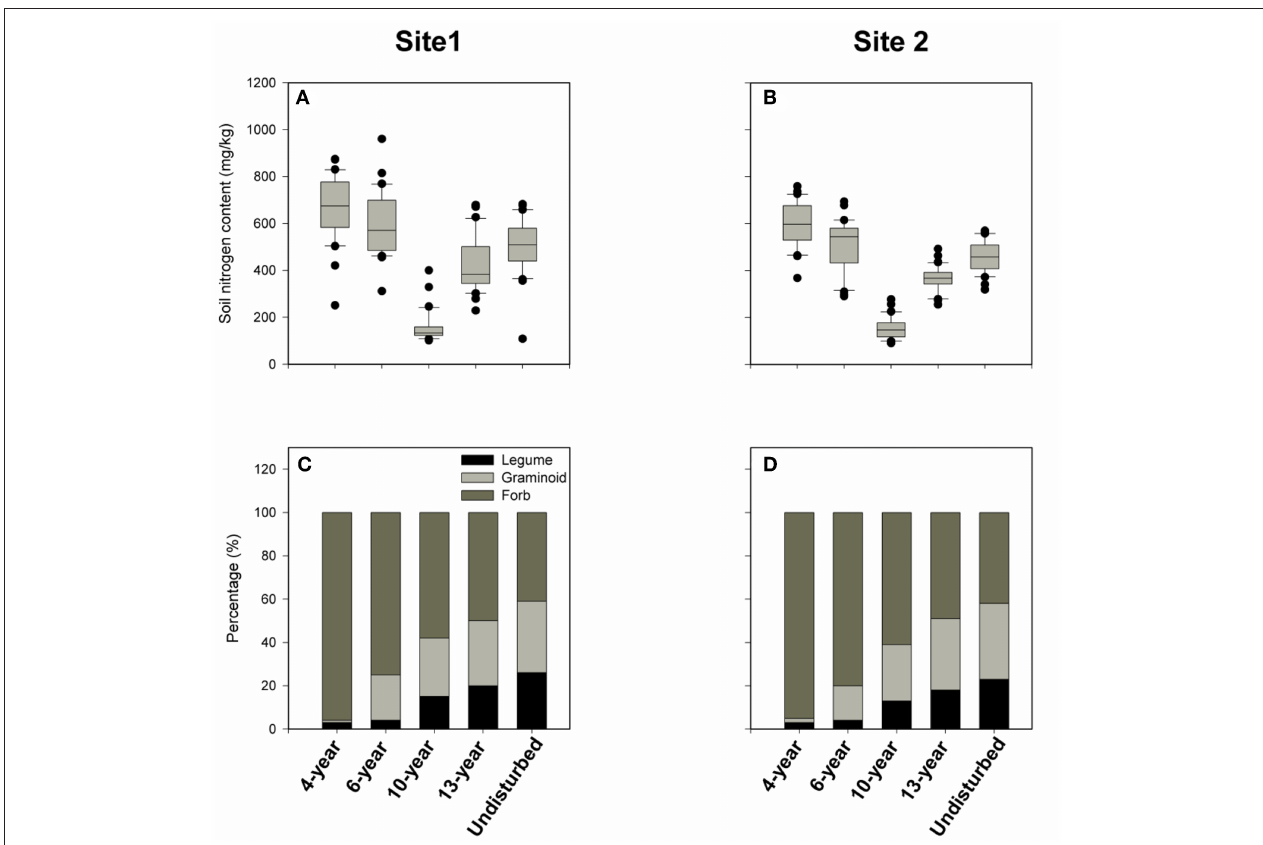
FIGURE 6 | Box plots of variation in soil total nitrogen and the respective percentages of the three main function groups (forb, graminoid, and legume species) among the 30 quadrats in each grassland of each successional age. (A,C) Represent soil nitrogen content and the respective percentages of the three main plant functional groups (legume, graminoid, and forb) in chronosequence 1, respectively. Likewise, (B,D) indicate soil nitrogen content and the individual percentage of the three main plant functional groups (legume, graminoid, and forb) in chronosequence 2